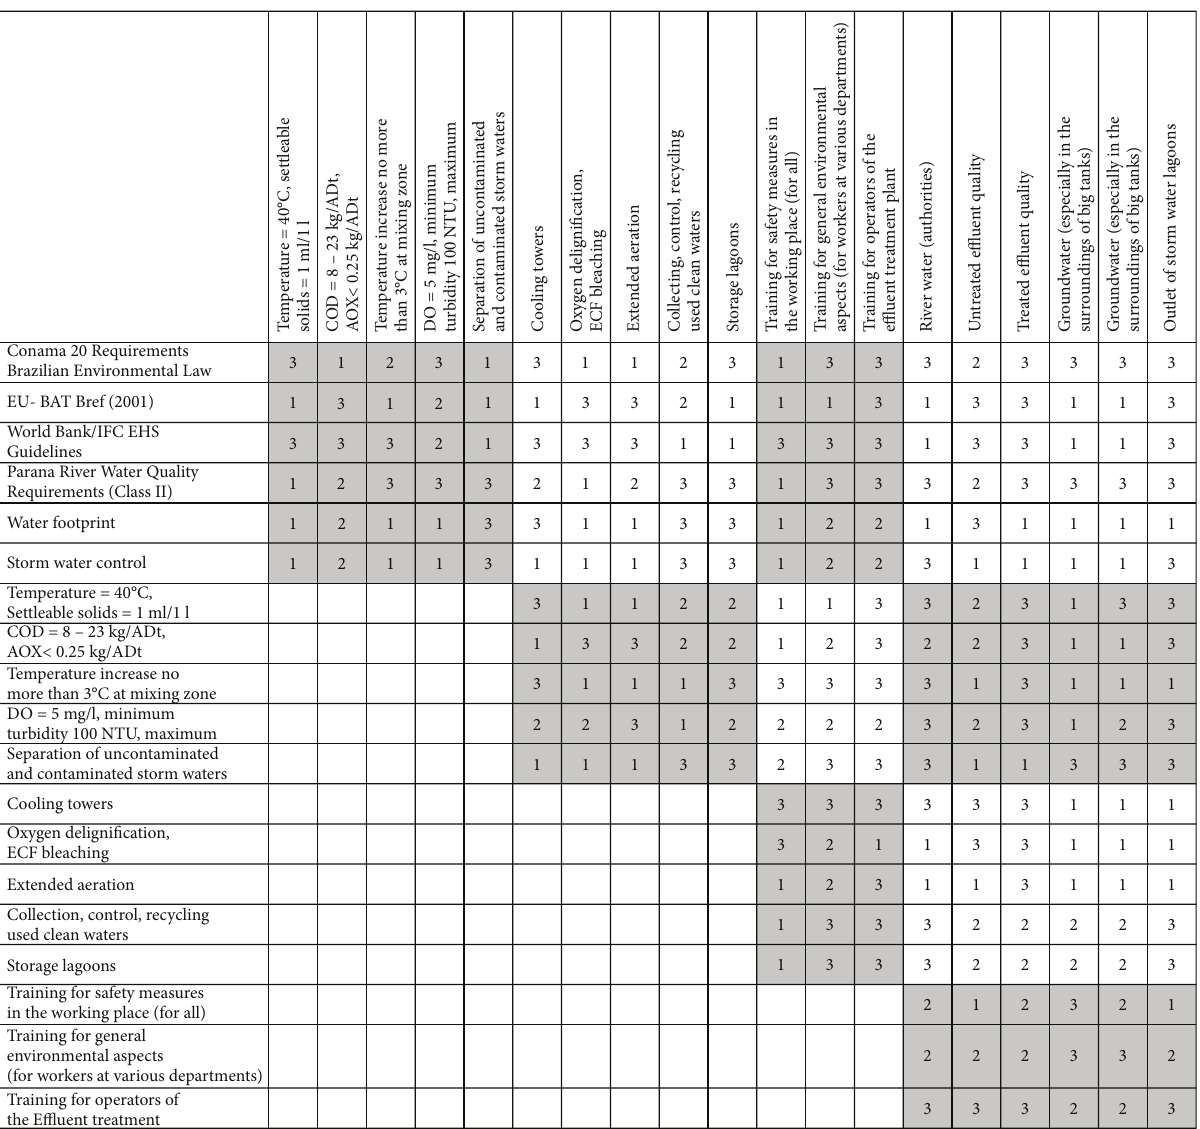
Figure 3: Cross-consistency assessment